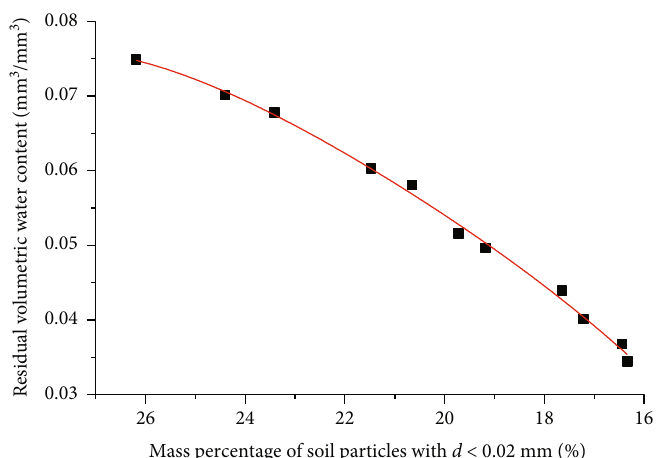
Figure 12: Relationship between mass percentage of particles ( d < 0 : 02 mm) and residual volumetric water content.